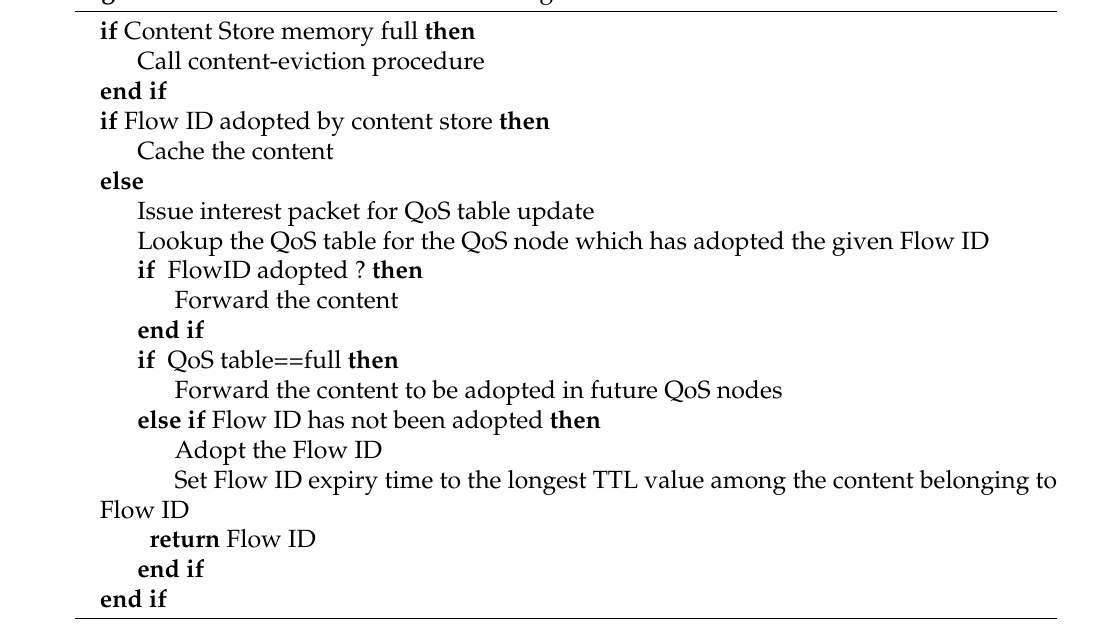
Algorithm 3 Content-admission-control